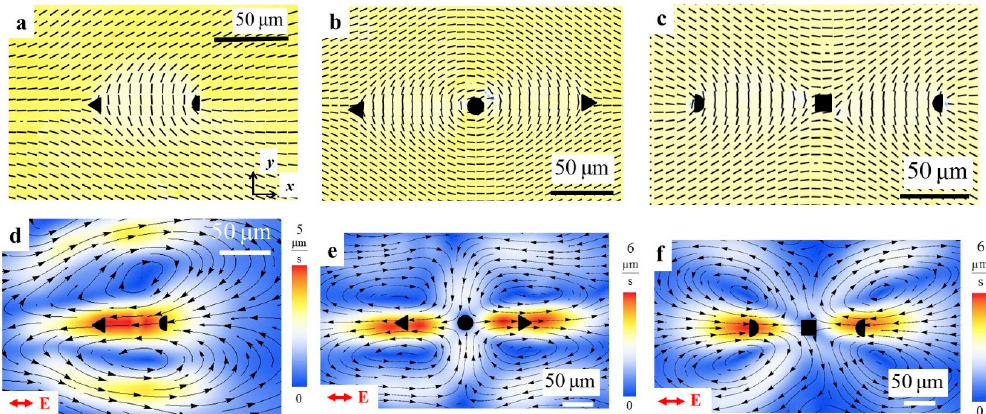
Figure 10. LCEO flows with pairs and triplets of topological defects demonstrated by Peng et al. [26]. ( a ) PolScope texture of a nematic cell with disclination pair − ½ (core marked by a triangle) and ½ (core marked by a semicircle); ( b ) Three disclinations ( − ½, 1, − ½) with +1 defect core marked by a circle; ( c ) Three disclinations (½, –1, ½) with –1 defect core marked by a square; ( d – f ) Corresponding LCEO flow patterns caused by an AC field in the patterned director fields shown in ( a – c ) respectively. Adapted with permission from [26].